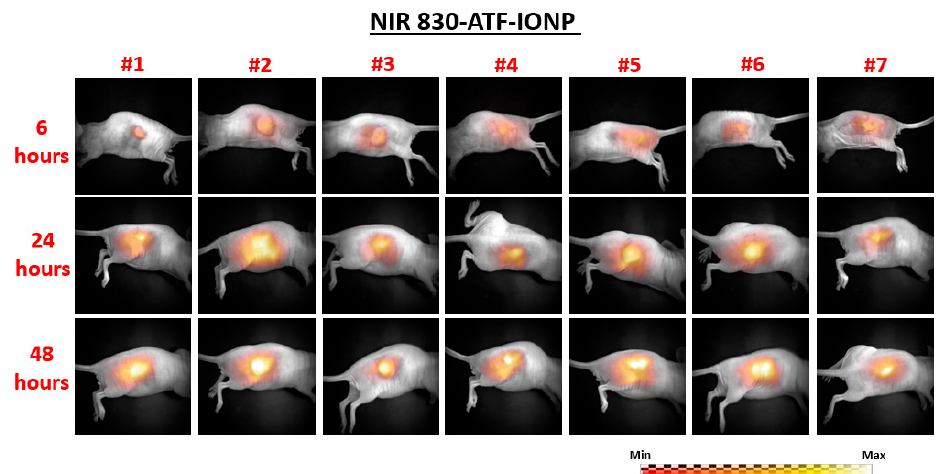
Figure 2. Planar fluorescence images of the seven mice in the urokinase plasminogen activator receptor (uPAR)-targeted imaging nanoprobes and near-infrared 830 dye-labeled magnetic iron oxide nanoparticles (NIR 830-ATF-IONP) group at 6, 24, and 48 h post injection of nanoprobes.